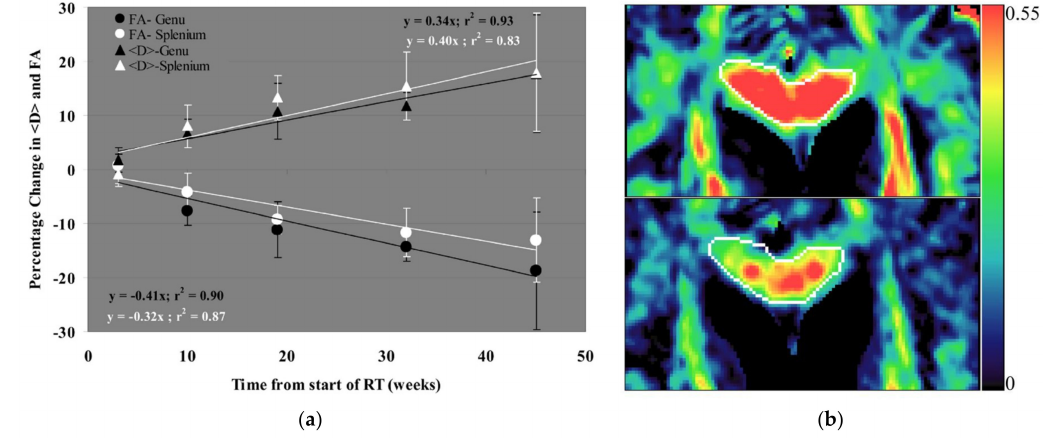
Figure 2. ( a ) Percentage changes of MD (here called <D>) and FA relative to pre-RT values in both genu and splenium during and after RT. ( b ) FA maps before RT (top) and 10 weeks after the start of RT (bottom) show decreasing FA in genu (outlined in white) after irradiation. Reprinted from Nagesh et al. [77] with permission from